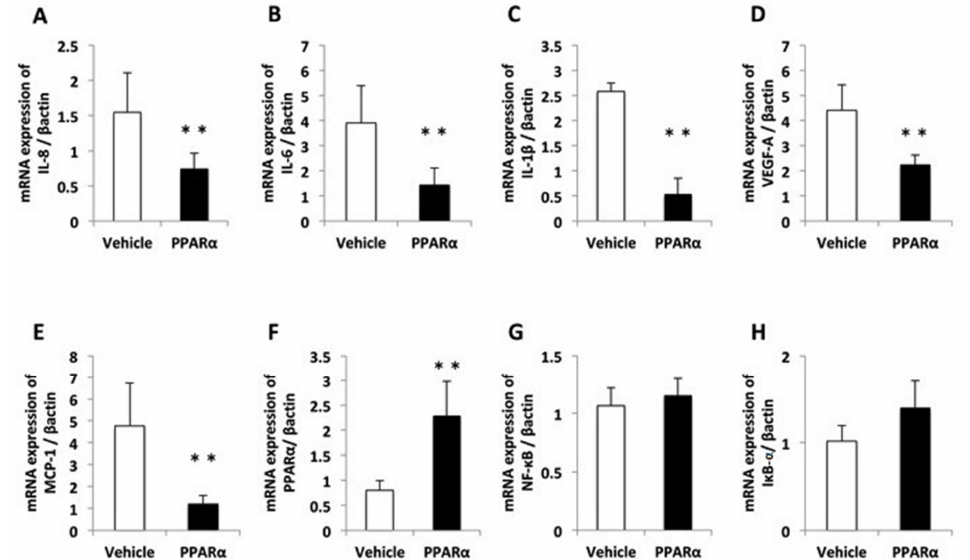
Figure 6. The expression of pro-inflammatory cytokines, chemokines, NF- κ B, and I κ B- α in the cornea after alkali burn injury. Quantification of the messenger ribonucleic acid expression levels of ( A ) IL-8 (CXCL8), ( B ) IL-6, ( C ) IL-1 β , ( D ) VEGF-A, ( E ) MCP-1, ( F ) PPAR α , ( G ) NF- κ B, and ( H ) I κ B- α . The messenger ribonucleic acid (mRNA) expression levels were measured with real-time reverse transcription–polymerase chain reaction (RT–PCR), and were normalized to the level of β -actin. A significant difference was observed between the vehicle and PPAR α groups at 6 h ( A – F ) after injury. The levels of NF- κ B and I κ B- α were no significant difference ( G , H ). The results are presented as the means ± standard errors. ** p < 0.01, compared with the vehicle group.